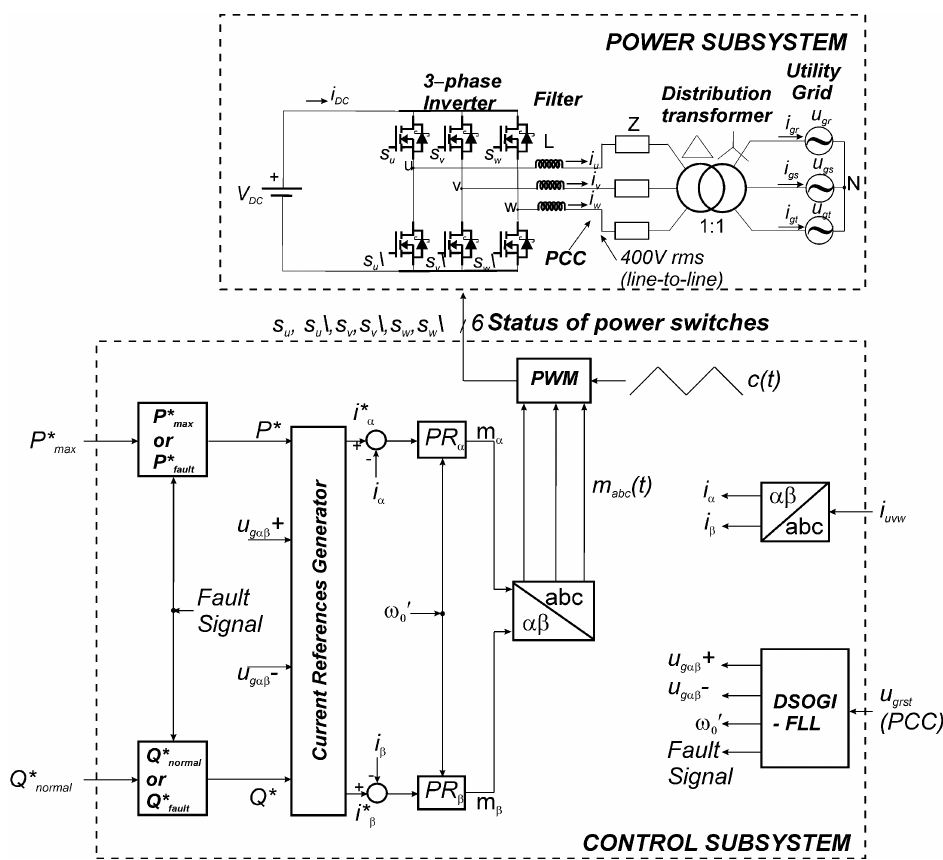
Figure 1. The grid-connected renewable energy system.